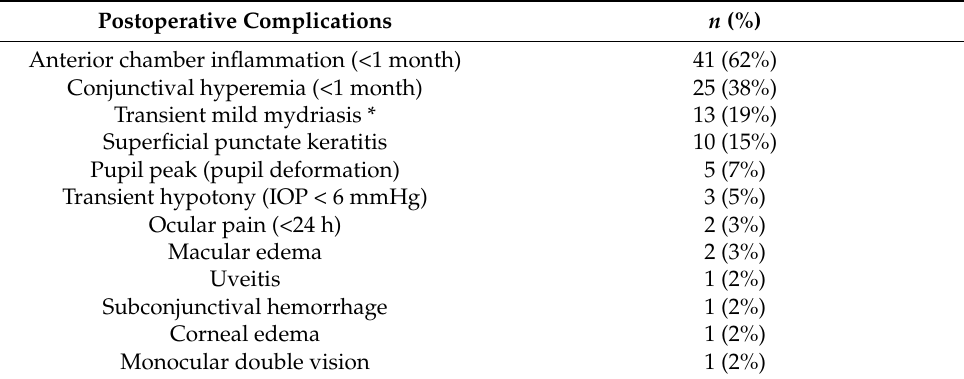
Table 3. Postoperative complications.